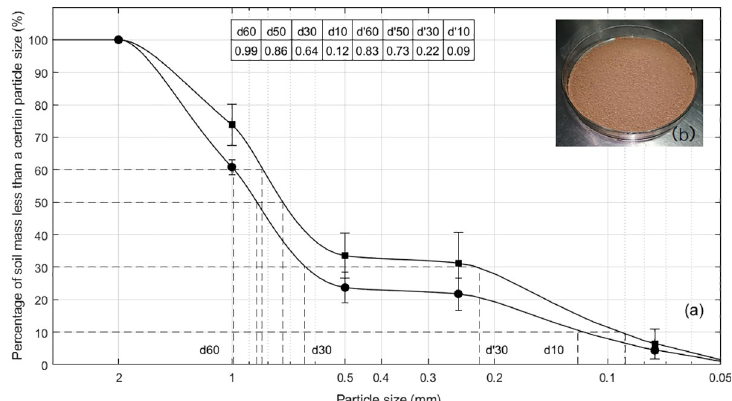
Fig 1. Soil material and its particle size distribution. (a) The accumulative size distribution curves of soil particles before (•) and after ( ■ ) experiments. Each set of marked points is an average of 3 separate screening operations, and error bars represent the RMS variations between operations. The solid lines are least square fits of these averages using the algorithm of shape-preserving interpolation. The table shows characteristic particle size of soil. According to observations, a large number of particle clusters formed from the cohesion of wet soil before air-drying, broke due to the experimental operations, leading to the difference between the two curves. (b) A photograph of the prepared